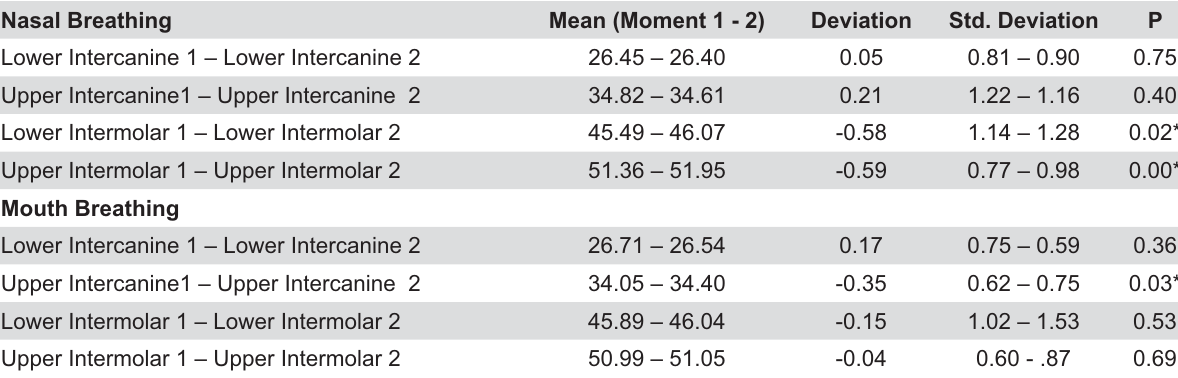
Figure 3- Pogonium cephalometric tracing with linear measurements Table 1- Comparison between intercanine and intermolar distances in nasal and mouth breathing according to the moments